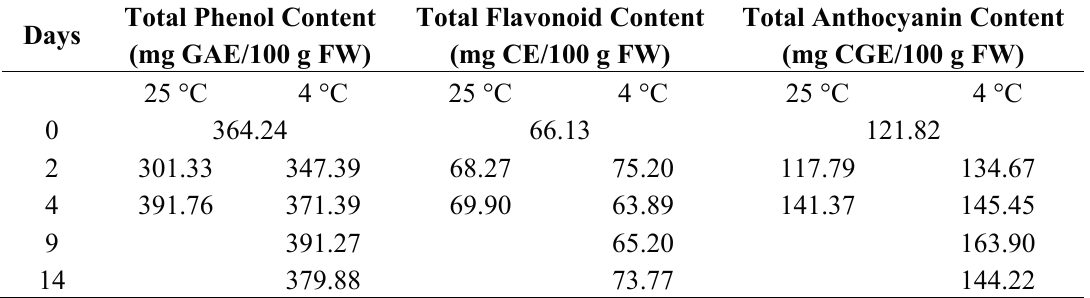
Table 13. Antioxidant components of blackberry fruits stored at 25 °C and 4 °C